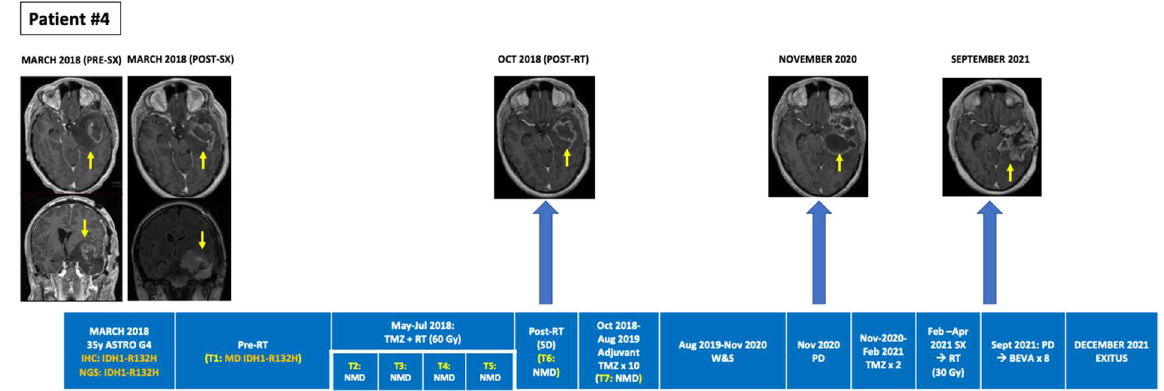
Figure 2. Tumour evolution in BEAMing ctDNA-positive patient #4. A 66-year-old man diagnosed with a large right temporal IDH1-R132H mutant and MGMT methylated glioblastoma underwent a subtotal resection. After surgery concomitant RT + TMZ was administered. A single adjuvant TMZ cycle was administered after RT due to clinical deterioration, partly due to a non-obstructive hydrocephalus that required a ventriculo-peritoneal valve placement. Plasma ctDNA analysis pre- and post-RT revealed no IDH1 mutations. Eight months after RT, in February 2018, progressive disease occurred with appearance of L1-L2 leptomeningeal dissemination that was treated with palliative RT (5 × 4 Gy). BEAMing plasma ctDNA analysis prior to L1-L2 irradiation, detected